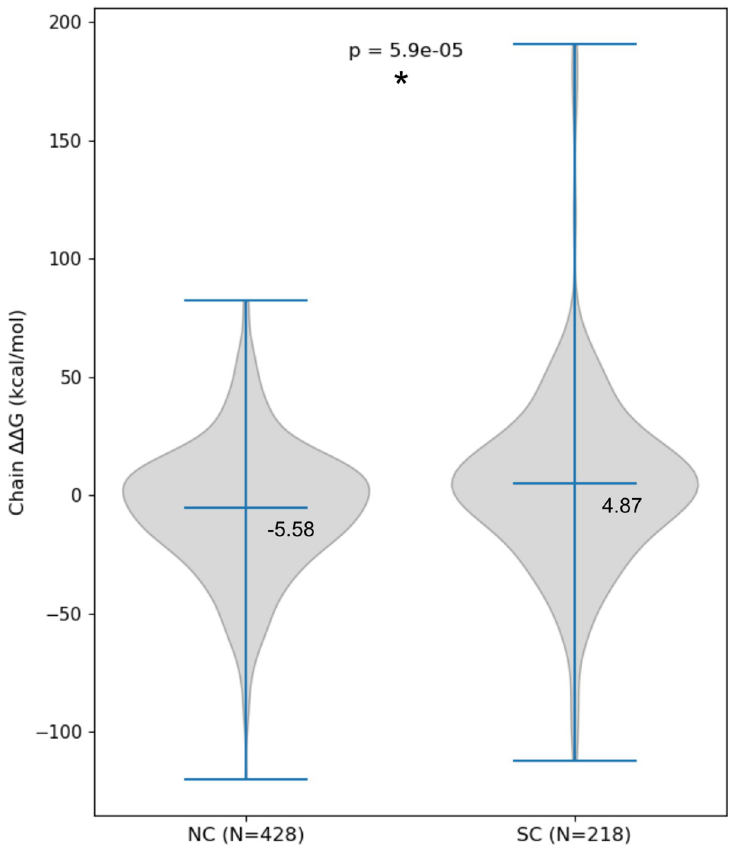
Fig 4. Overall effect of PTMs on the protein-protein binding. Chain ΔΔ G bind values are significantly more stabilizing for PTMs found in normal when compared to those identified in stress conditions, though the effect size is small (Cohen’s d =